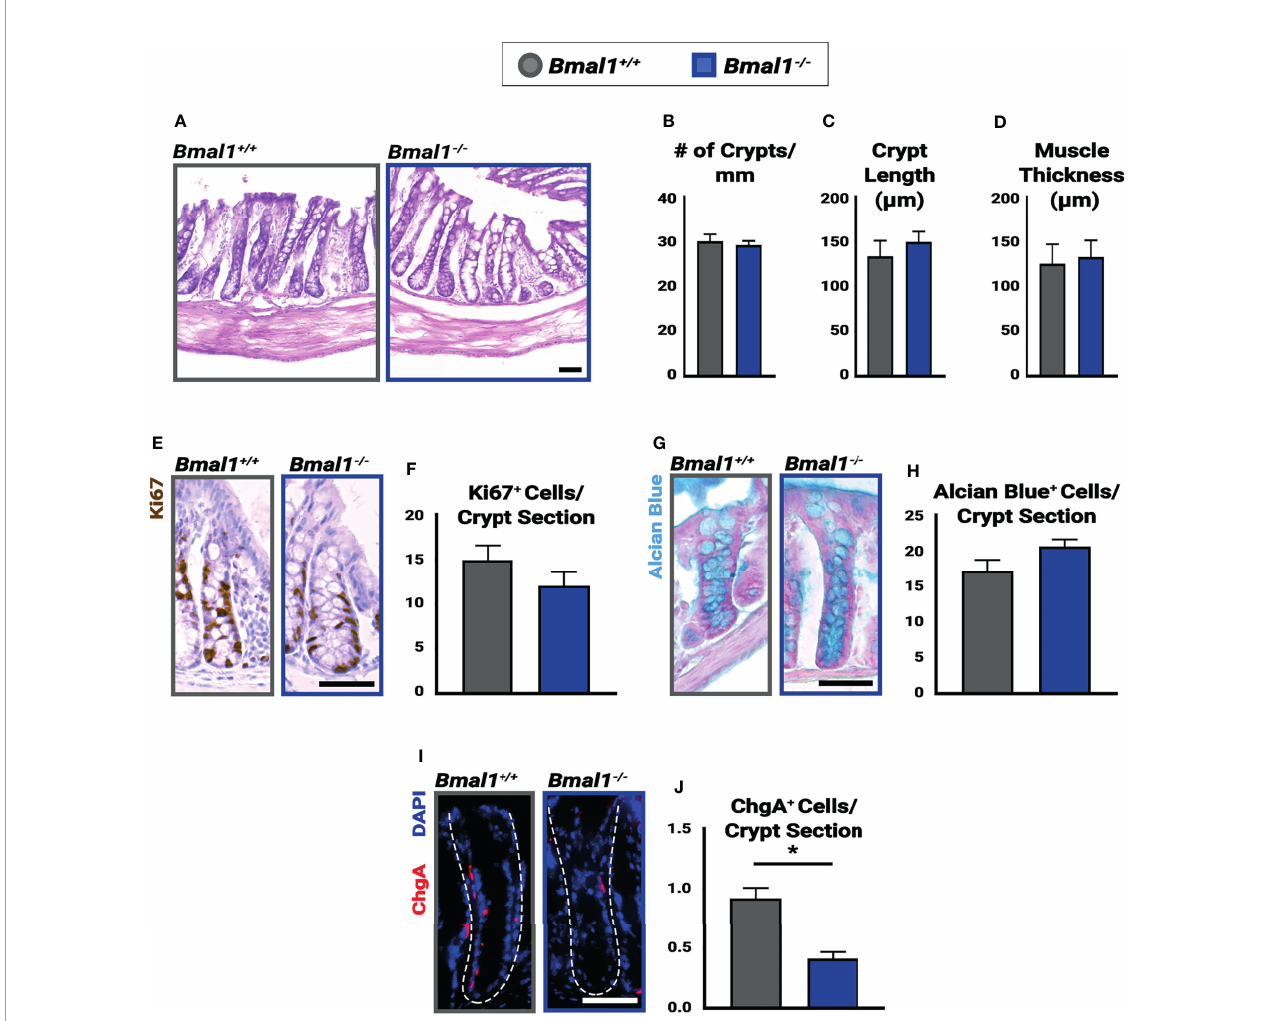
FIGURE 1 | Bmal1 -/- mutants have no signi fi cant colon phenotype but show decreased numbers of enteroendocrine cells. Untreated Bmal1 +/+ control and Bmal1 -/- mutant colon tissues were collected at ZT4 and examined for epithelial differences. (A) Hematoxylin-eosin staining shows no difference in morphology between genotypes. No difference was seen in (B) number of crypts along the colon (crypts/mm) (Unpaired t -test, p=0.6627), (C) average crypt length (µm) (Unpaired t -test, p=0.4786), (D) or average muscle thickness (µm) (Unpaired t -test, p=0.8027). (E, F) Goblet cells (marked by Alcian Blue) are present in similar amounts in Bmal1 +/+ control and Bmal1 -/- mutant colons (Unpaired t -test, p=0.2334). (G, H) Bmal1 +/+ control and Bmal1 -/- mutant crypts were tested at three timepoints over the day (ZT0, ZT4, and ZT12) in order to quantify Ki67+ (brown; labels cells in S/G2/M phases) proliferating cells. No signi fi cant differences in cell proliferation were detected at any time (graph combines all three times, Unpaired t -test, p=0.1427). (I, J) A decrease in enteroendocrine cell population (Chromogranin A in red) is noted in Bmal1 -/- mutant colons (Unpaired t -test, *p=0.0012). (All error bars represent SEM. Scale bar = 50µm. Dashed lines indicate